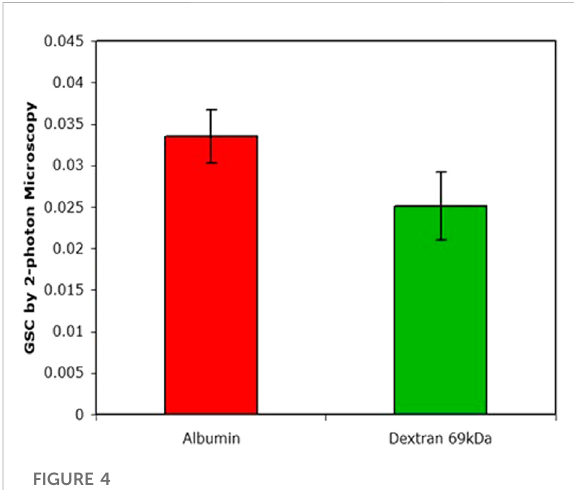
FIGURE 4 The GSC as determined by 2-photon microscopy. Plasma levels after 24 h of injection were 38% for albumin and < 1% for dextran (data from (Russo et al.,